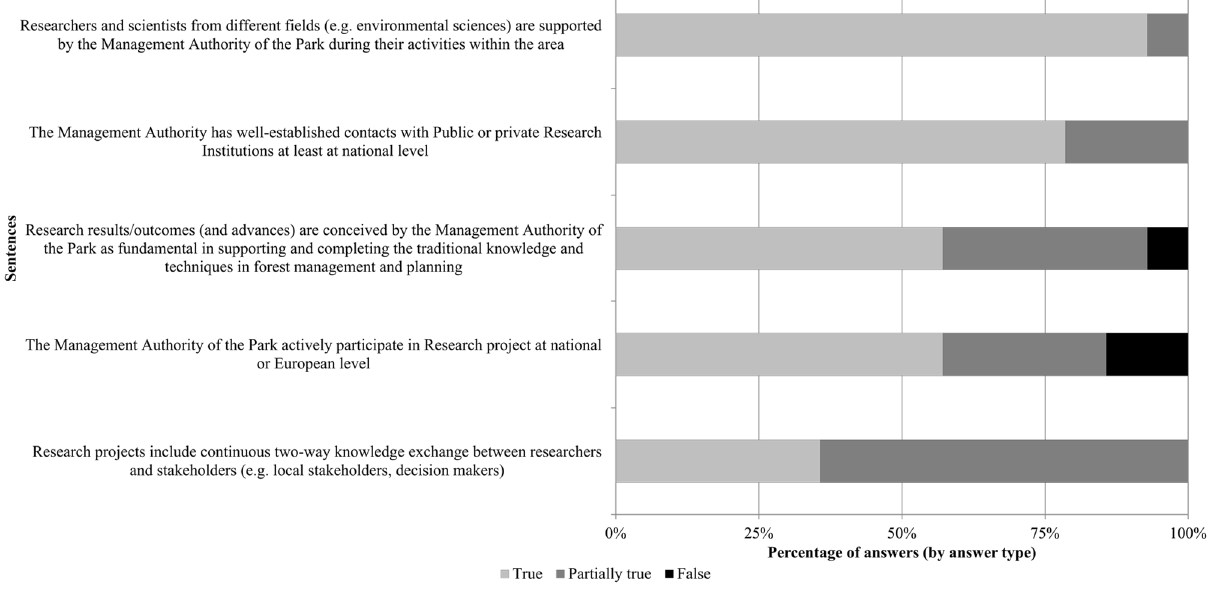
Figure 7. Bar chart showing the relative percentage of respondents to several